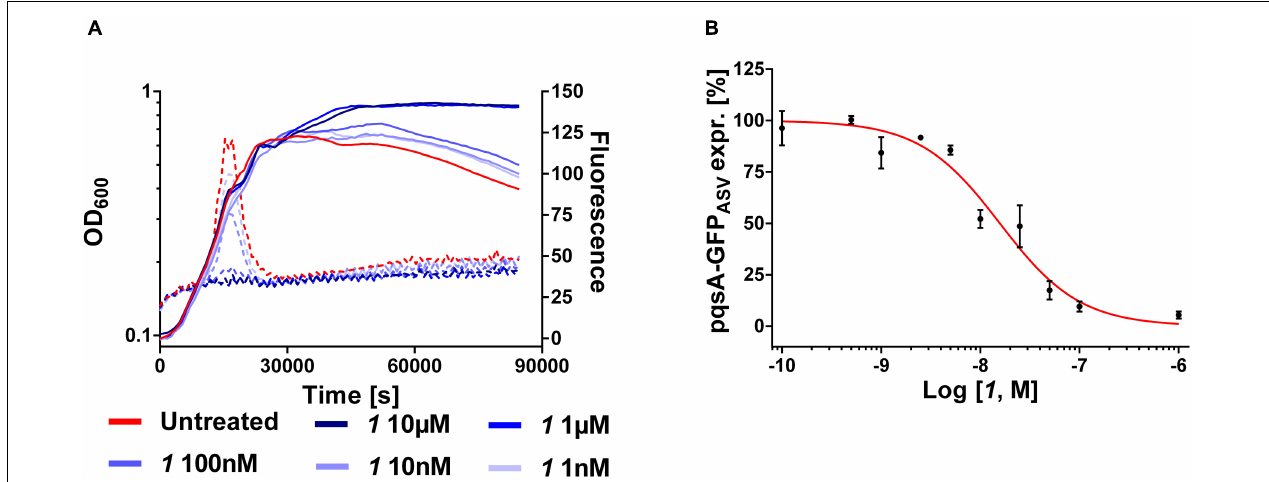
FIGURE 5 | Expression of pqsA-GFP ASV (dotted lines) and growth curves (solid lines) of Pseudomonas aeruginosa treated with 1 (A). IC 50 curve of 1 (B) . The “ x ” axes indicate the logarithm of the concentration of the antagonists in molar units (M). The error bars indicate Standard Error of the Mean.